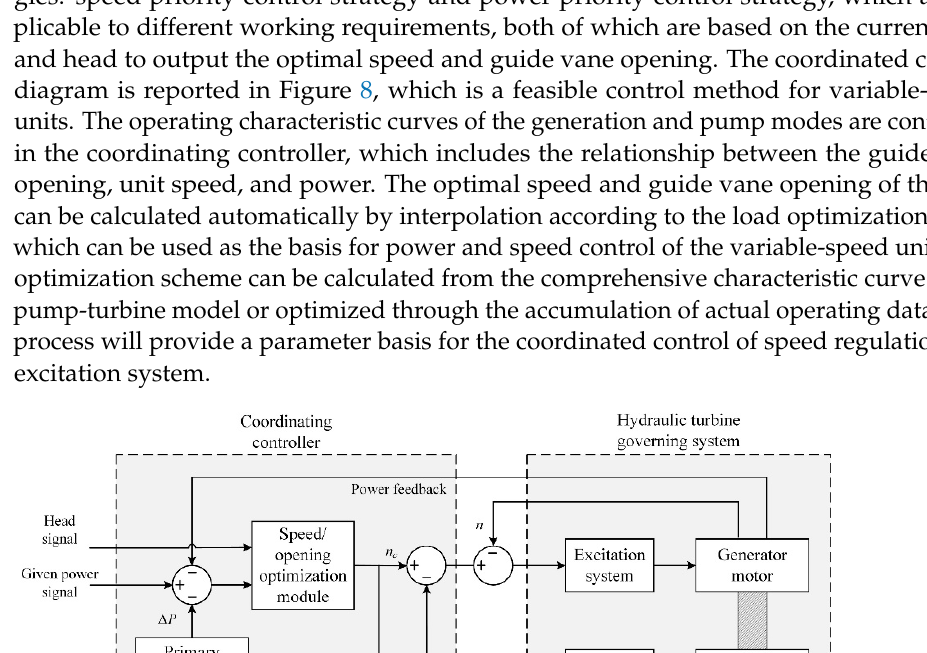
Figure 9. Hill diagram of the model pump-turbine. Now two function curves 𝑓 (cid:2869) and 𝑓 (cid:2870) are obtained, both with independent variables Q 11 . When the system receives the current output power P c and head values H c , the corre- sponding optimal efficiency η c , unit speed n 11c and unit discharge Q 11c can be obtained according to the fitting calculation. In addition, the relationship between guide vane open- ing and other unit parameters is contained in Figure 9. Therefore, the optimization process